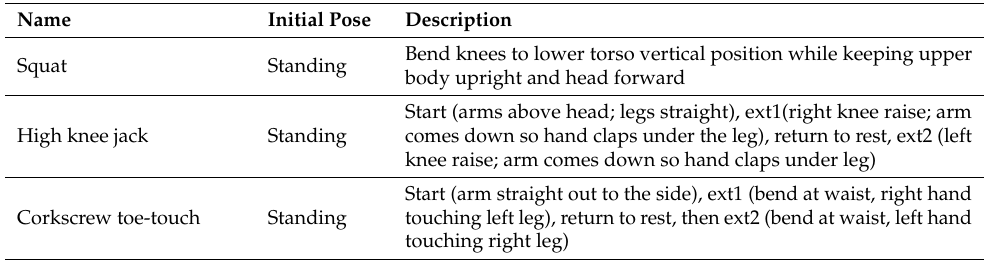
Figure 2. Distributions of the fatigue levels reported by participants in the experiment: ( a ) squat; ( b ) high knee jack; ( c ) corkscrew toe-touch. Table 2. Exercise descriptions.